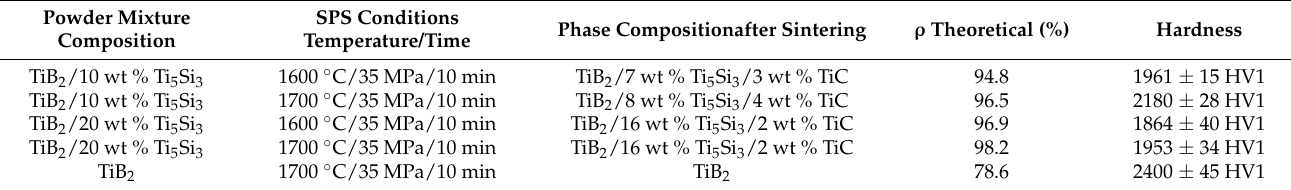
Table 1. Initial phase composition of the powder mixtures and phase composition of the samples after SPS sintering, their hardness and relative density.